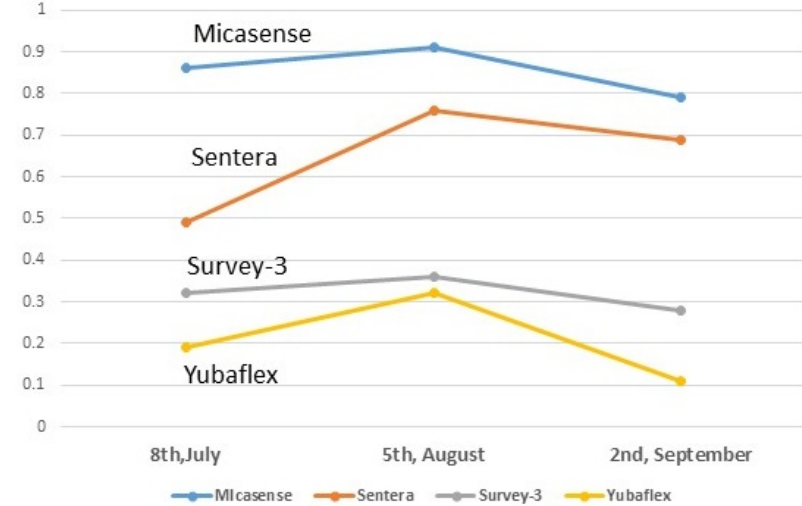
Figure 6. NDVI temporal changes of paddy field by four different cameras.